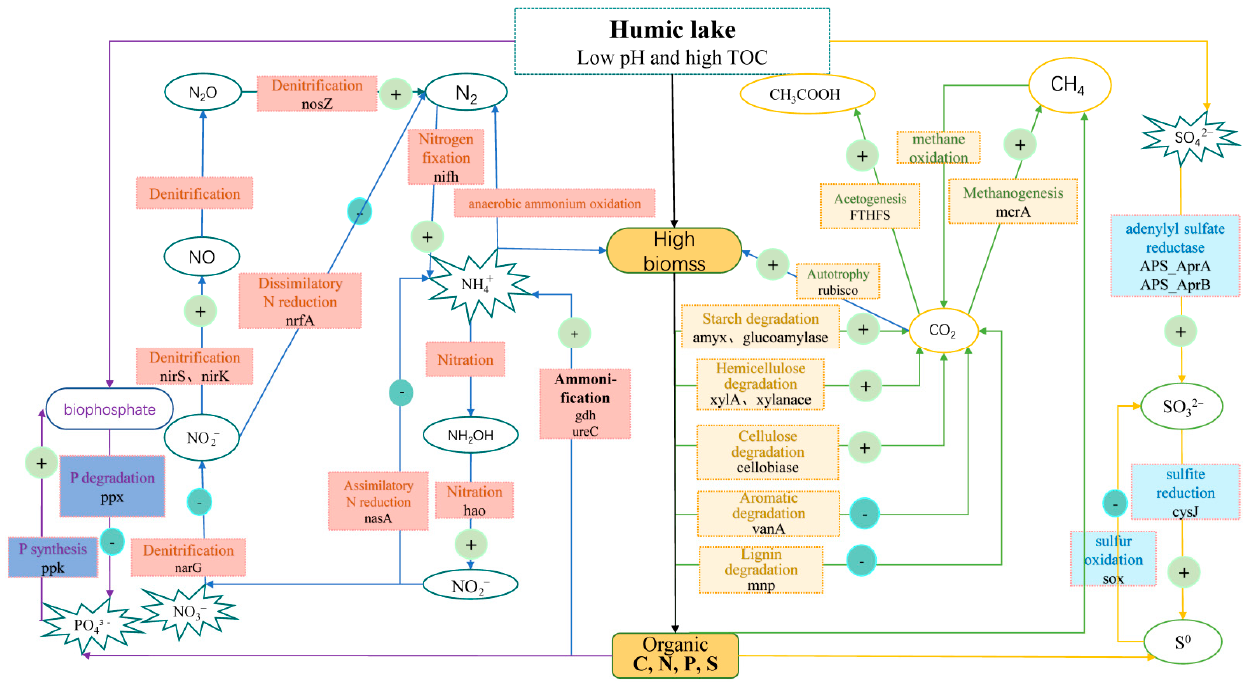
Figure 5. A conceptual model of the microbial metabolic processes in the HL. The “+” indicates that the microbes facilitate the process, and the “-” indicates that the microbes inhibit the process. Carbon, nitrogen, phosphorus, and sulfur flows are represented by green, blue, purple, and orange arrows, respectively. Biomass pools are shown as blue rectangular frames, and nutrients that could be directly assimilated by microbes are displayed by blue explosive graphics.